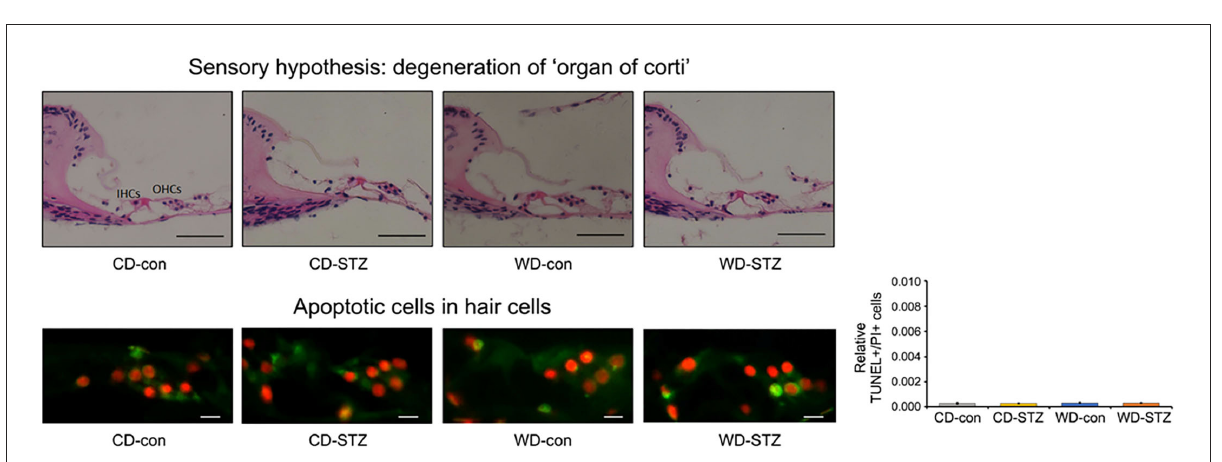
FIGURE8 Histological analysis of the organ of Corti. No significant difference was noted in the TUNEL + /PI + ratio in hair cells. The average count of apoptosis cells was taken from at least eight cross-sectional images. Scale bars correspond to 50 µ m (upper panel) and 1 µ m (lower panel)